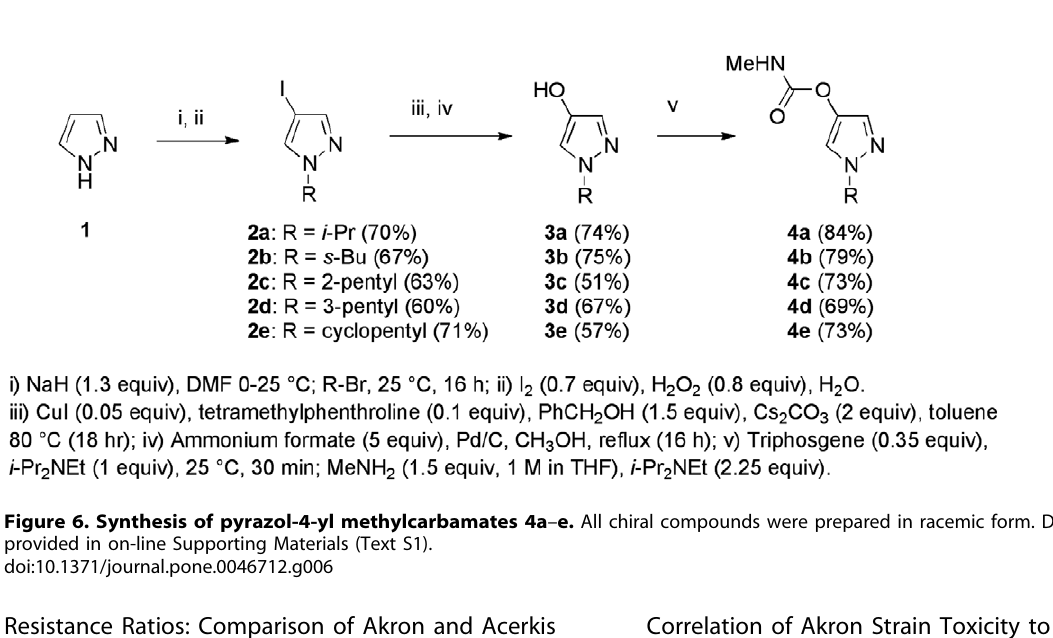
Figure 6. Synthesis of pyrazol-4-yl methylcarbamates 4a – e. All chiral compounds were prepared in racemic form. Detailed procedures are provided in on-line Supporting Materials (Text S1).